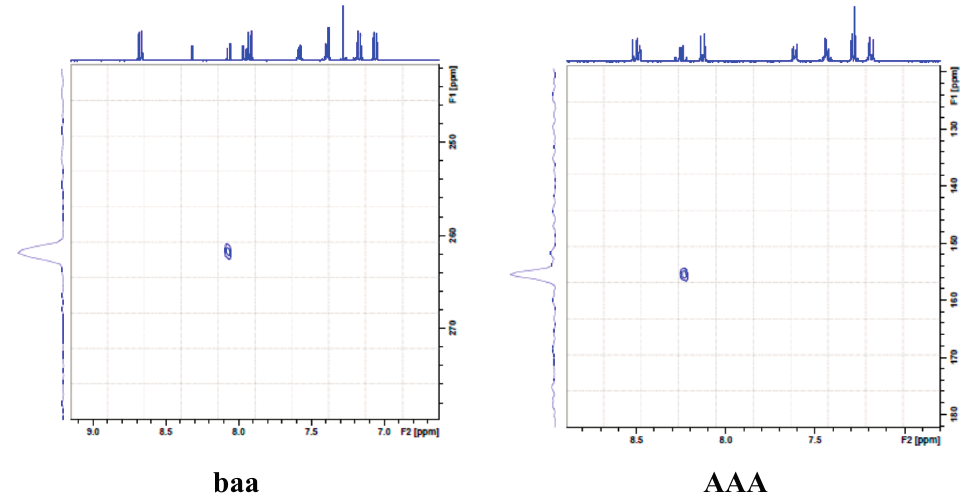
Figure 3. 1 H- 15 N NMR spectra of 5g in CDCl 3 ( baa ) and in CDCl 3 +TFA ( AAA ) using nitromethane as an external